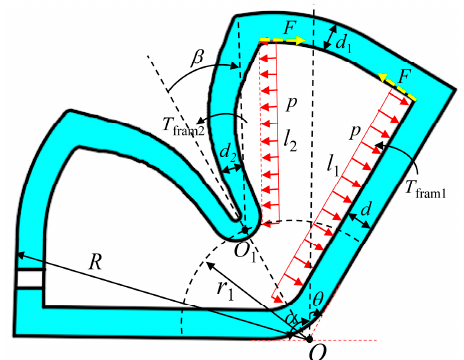
Figure 6. Force analysis of joint